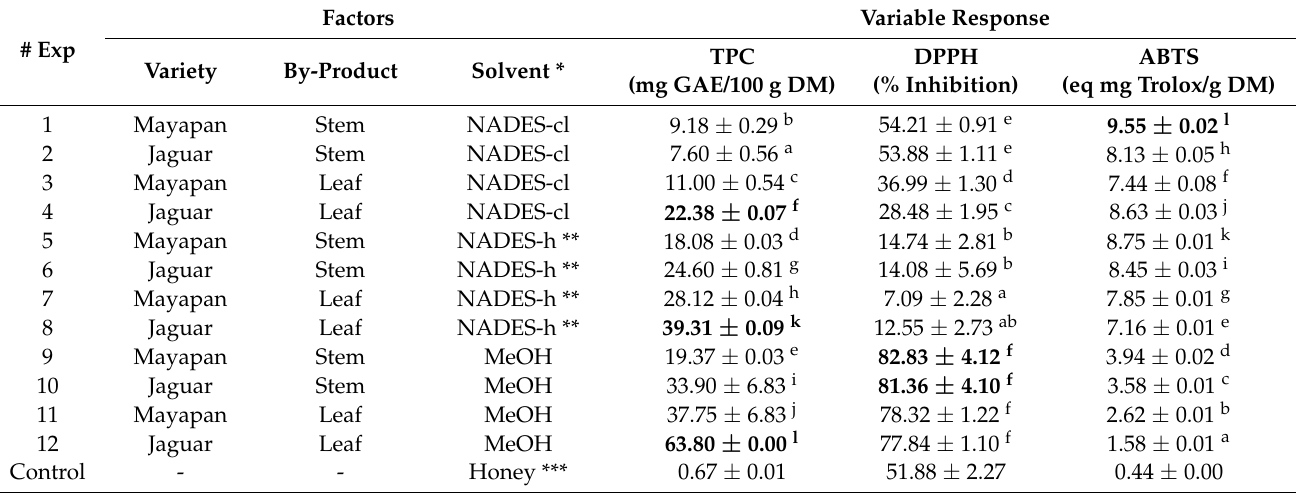
Table 1. Total polyphenol content and antioxidant capacity of extracts obtained by UAE from by-products of habanero pepper ( Capsicum chinense